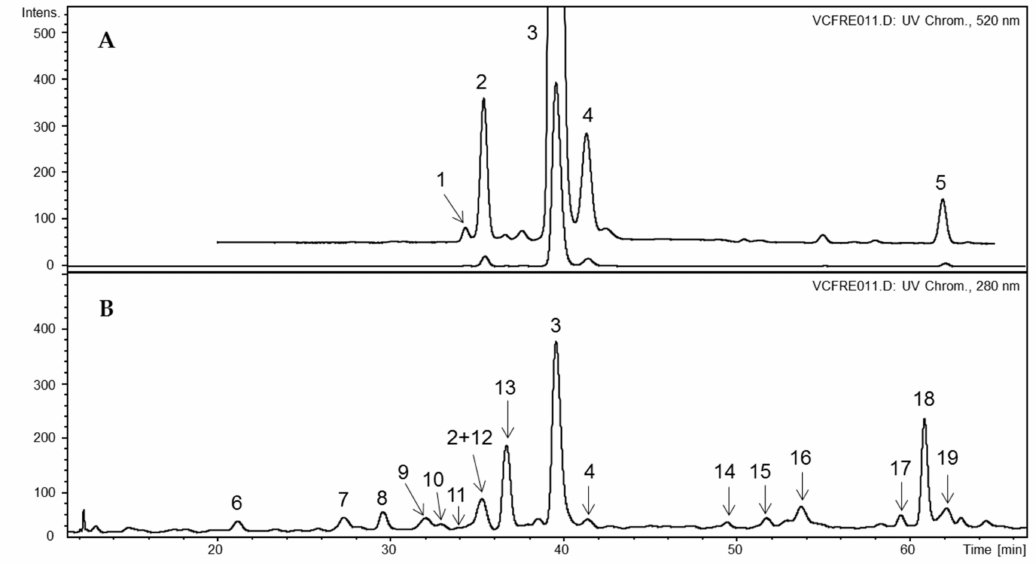
Figure 1. HPLC chromatograms at 520 nm ( A ) and 280 nm ( B ) of hydroalcoholic extracts from strawberry